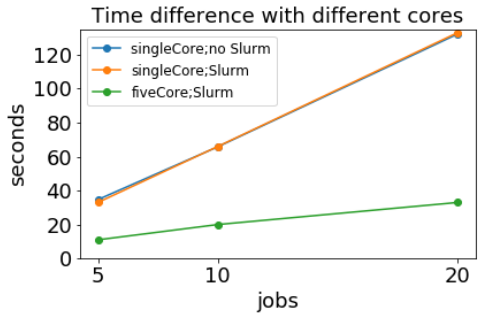
Figure 5. Illustration of Slurm performance. Overlapping blue and orange lines show that there is nearly no noticeable overhead cause by